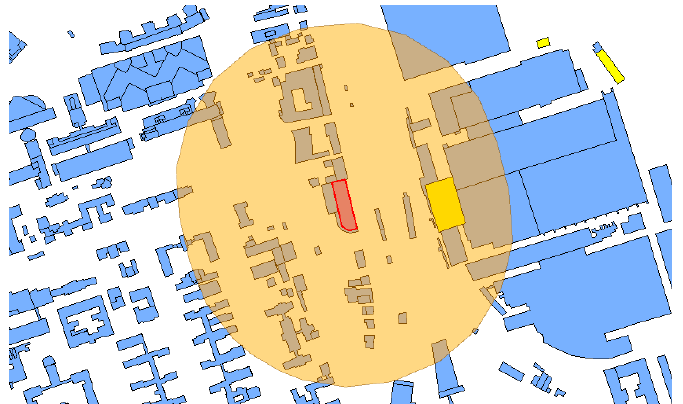
Figure 6. Finding the supermarkets in front of a given building and at a short distance.